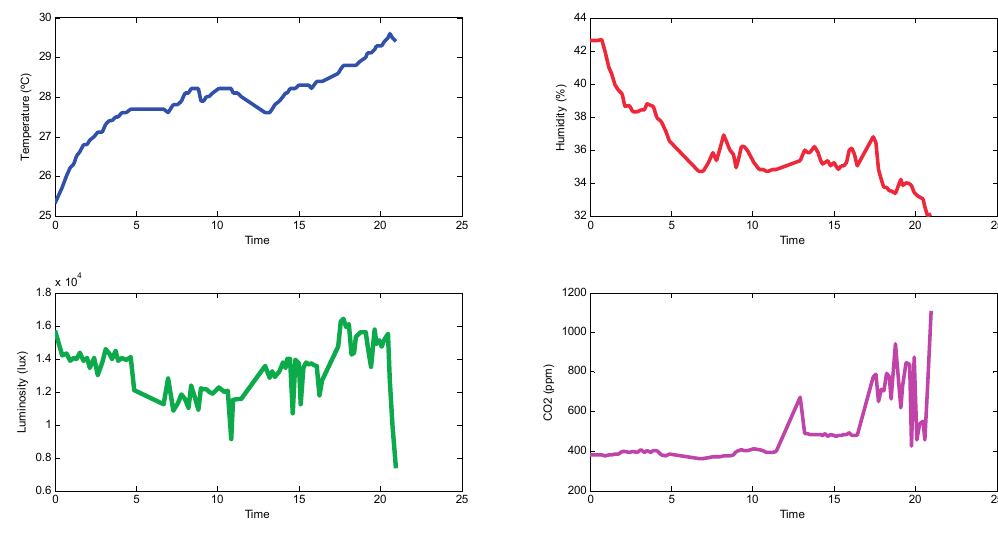
Figure 12. Variable dependence with